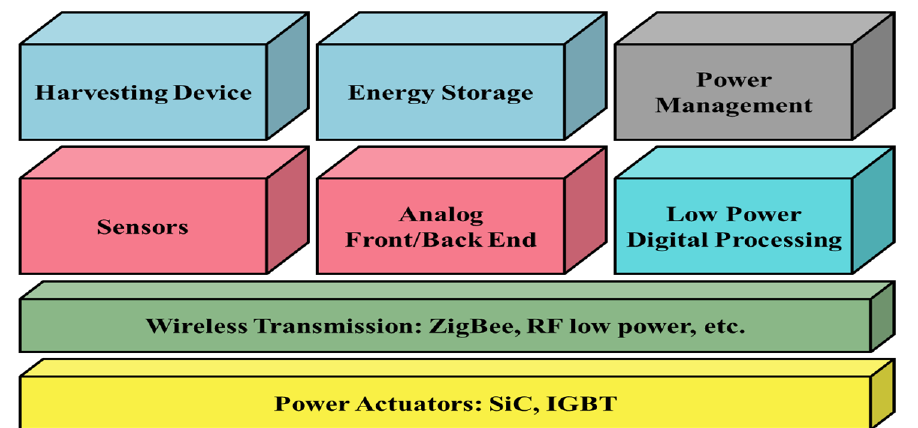
Figure 2. Typical components of smart systems.